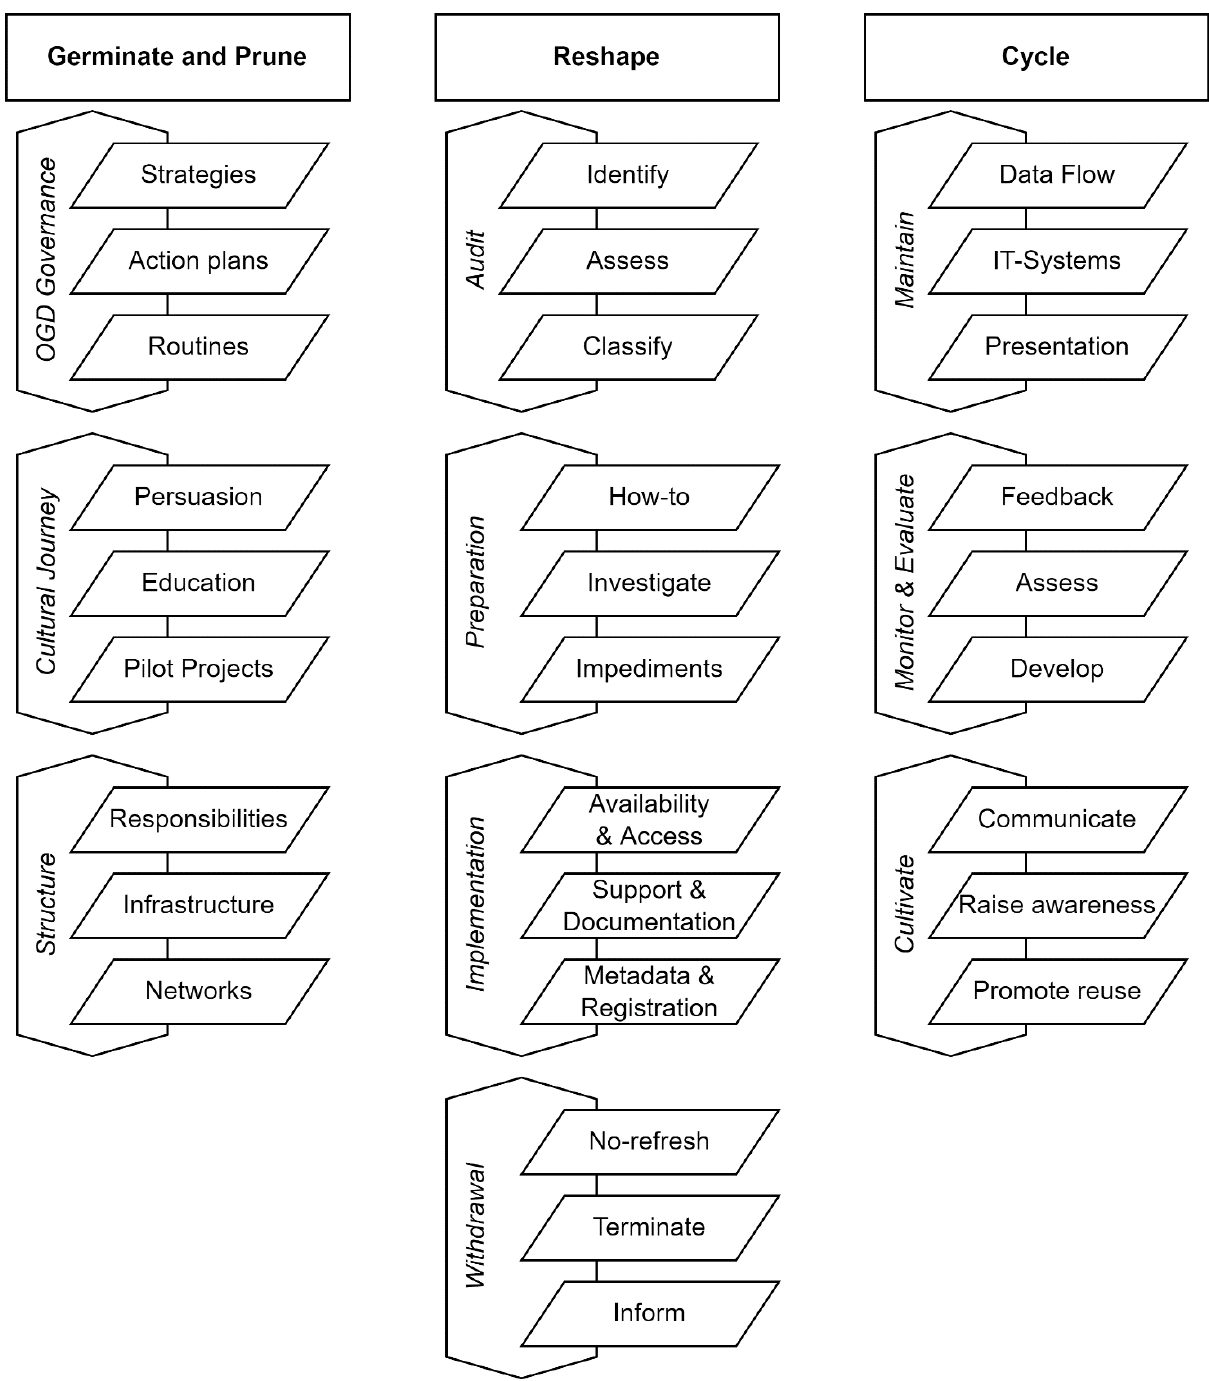
Figure 4: Detailed overview of the fields of work